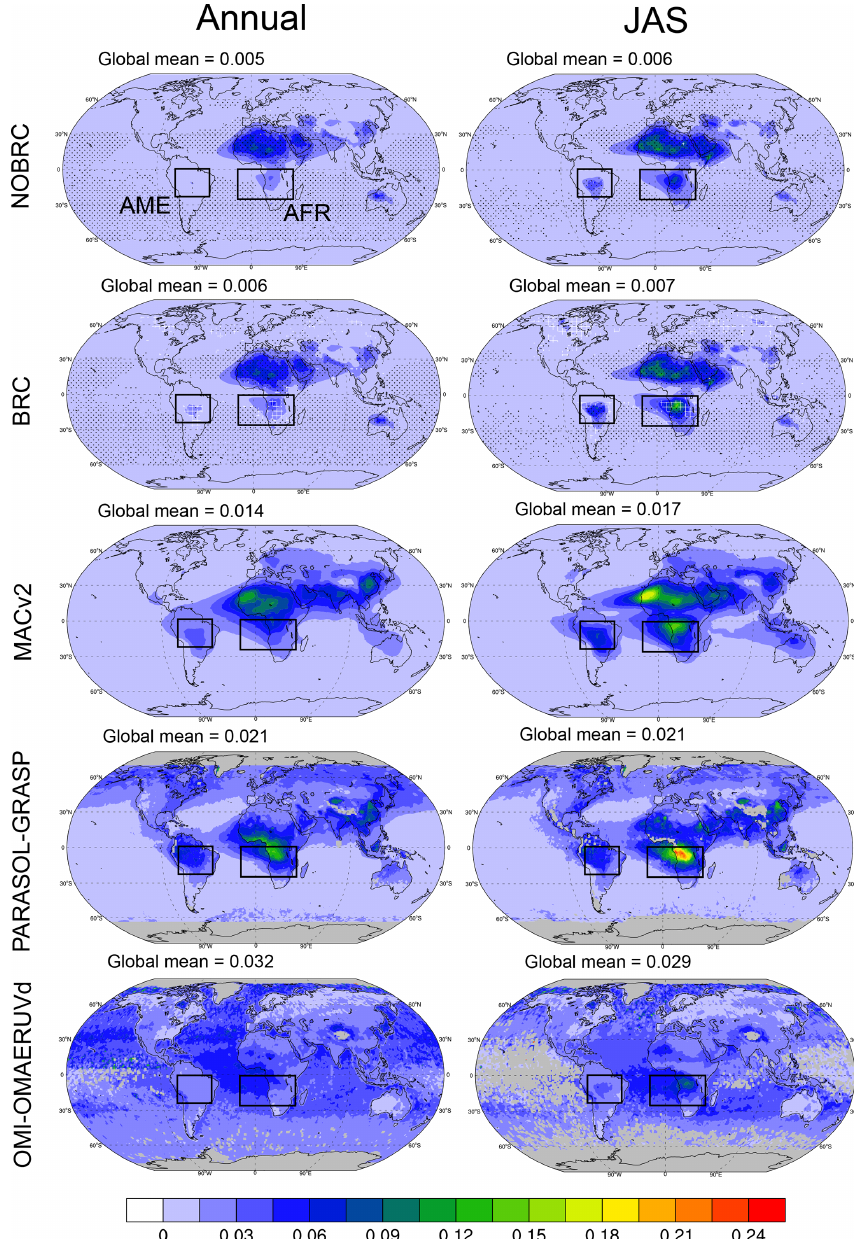
Figure 11. Same as Fig. 8 but for the AAOD (440nm; see Tables 2 and 3 for details).